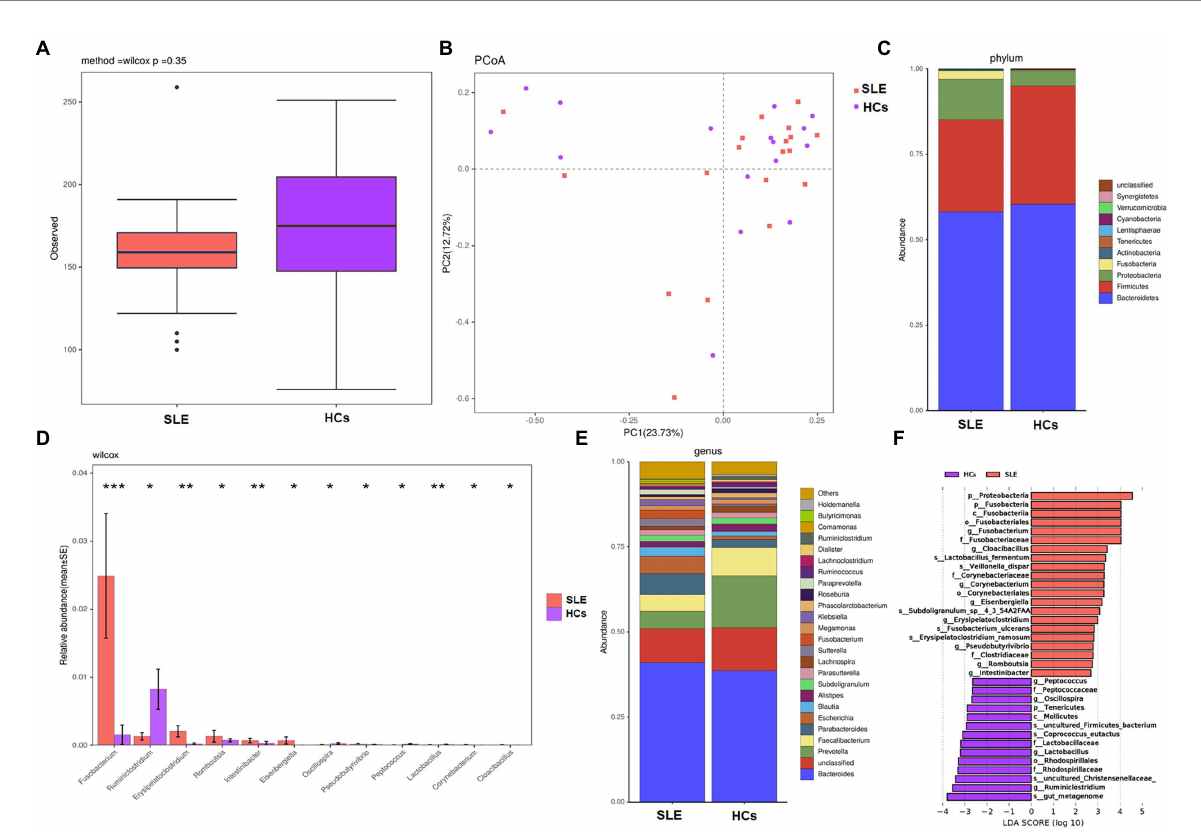
FIGURE 3 Diversities and compositions of gut bacteria between SLE and HCs. (A) Alpha diversities with observed species for SLE compared with HCs; (B) principal coordinate analysis (PCoA) on Bray-Curtis distance of the bacterial microbiota community structures in SLE and HCs; (C) the relative abundance of bacteria at phyla level of SLE and HCs; (D) the relative abundances of SLE and HCs at genus level were among the top 12 differences. (E) The relative abundance of bacteria at genus level of SLE and HCs; (F) taxonomic differences in bacterial composition between SLE and HCs by LEfSe